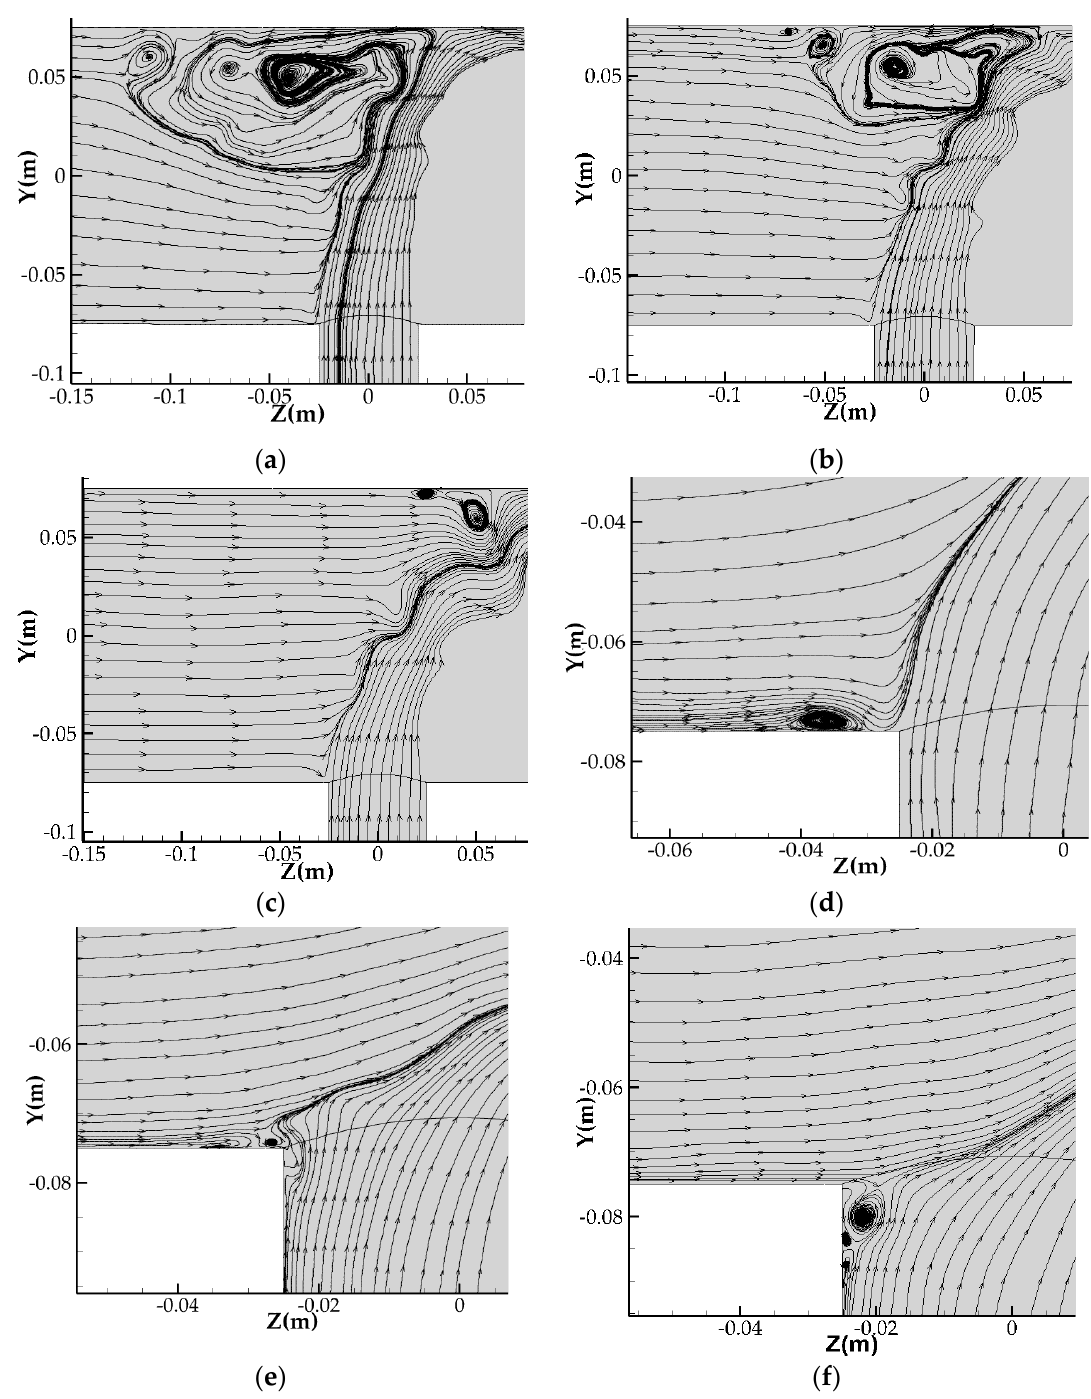
Figure 12. Streamlines in y–z plane of three impinging jet cases, one deflecting jet case, and tow wall jet cases at X = 0: ( a ) Case1 with M R = 0.05; ( b ) Case2 with M R = 0.1; ( c ) Case4 with M R = 0.2; ( d ) Case5 with M R = 0.8; ( e ) Case7 with M R = 11.5; ( f ) Case12 with M R = 32.